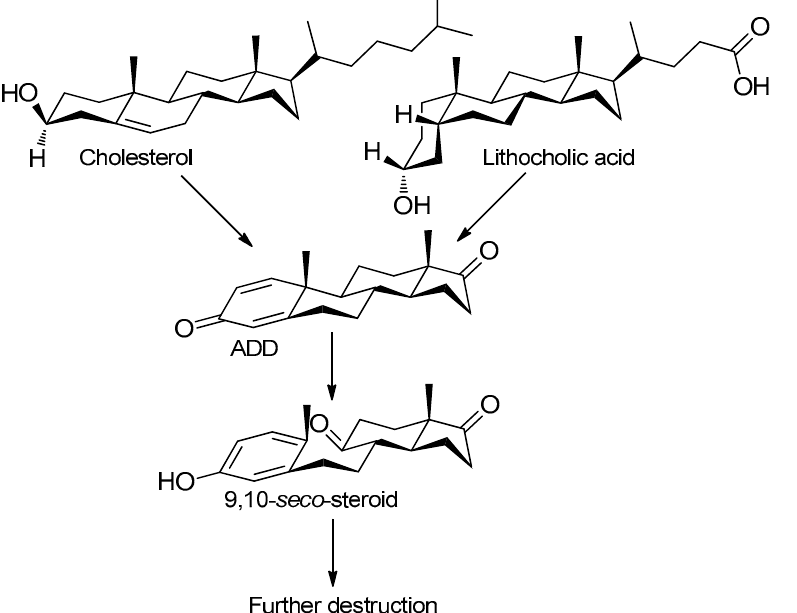
Figure 1. Principal scheme of steroid degradation via androsta-1,4-diene-3,17-dione (ADD) and 9,10- seco -pathway. I –Cholesterol, II –Lithocholic acid (LCA), III –ADD, IV –9,10- seco -steroid. Structurally, cholic acids ( II ) differ from cholesterol (I) by cis -A/B-ring juncture, α -orientation of hydroxyl at C3, saturated steroid core and a C5 acyl side chain attached to C17 (Figure 1). Unlike